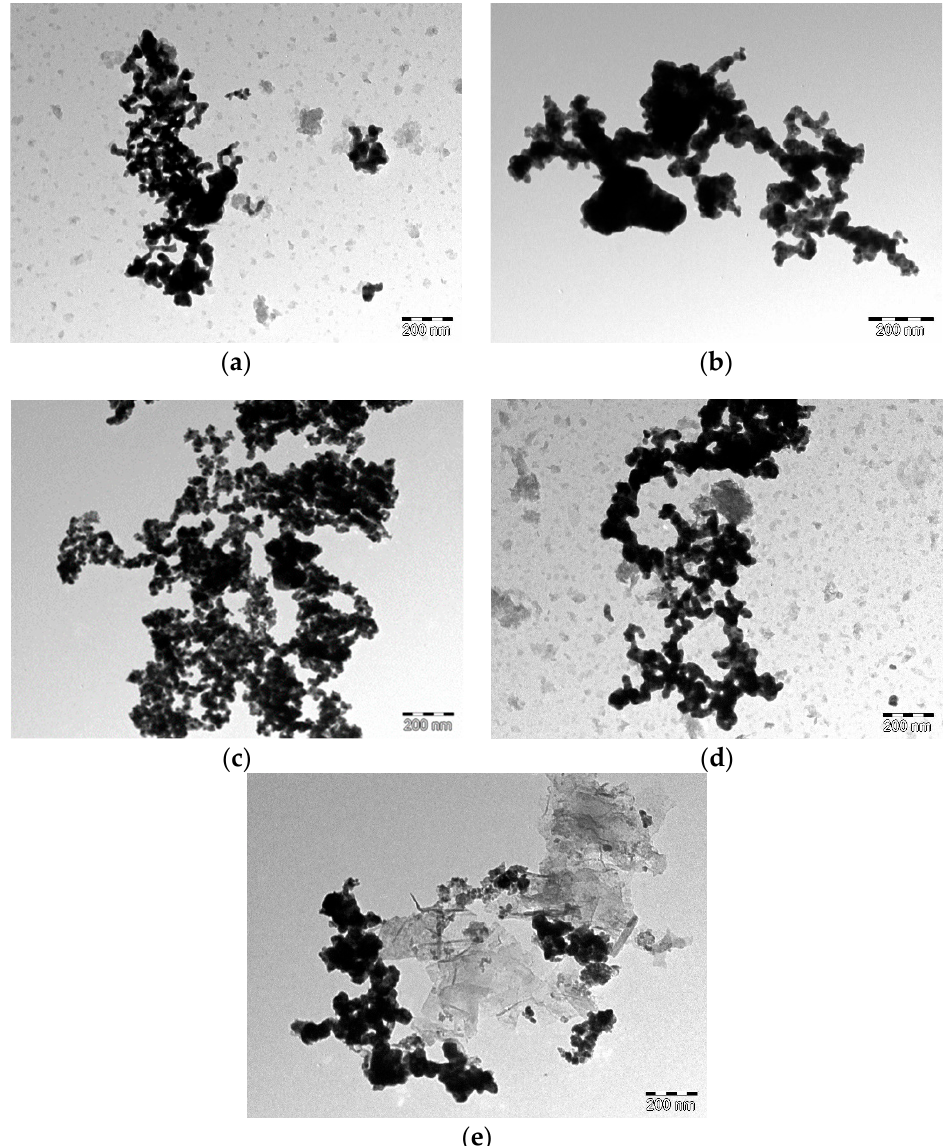
Figure 4. Transmission electron microscopy (TEM) images for the synthesized binary palladium PdNi x alloys ( a ) PdNi 1 , ( b ) PdNi 2 , ( c ) PdNi 3 , ( d ) PdNi 4 , ( e ) PdNi-rGO.